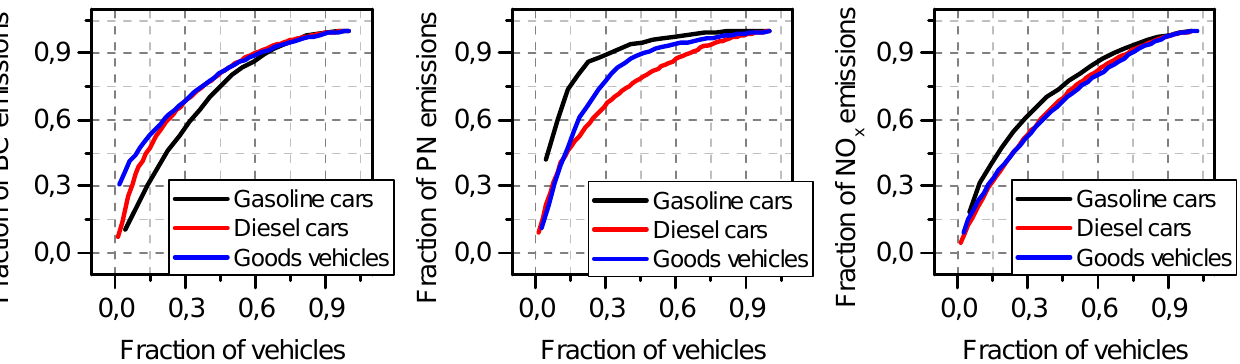
Figure 5. Cumulative distribution of all vehicle emissions. Fractions of vehicles are distributed from highest to lowest emitting vehicles. The result shows that 10% of vehicles contribute about a half of total BC and NO x